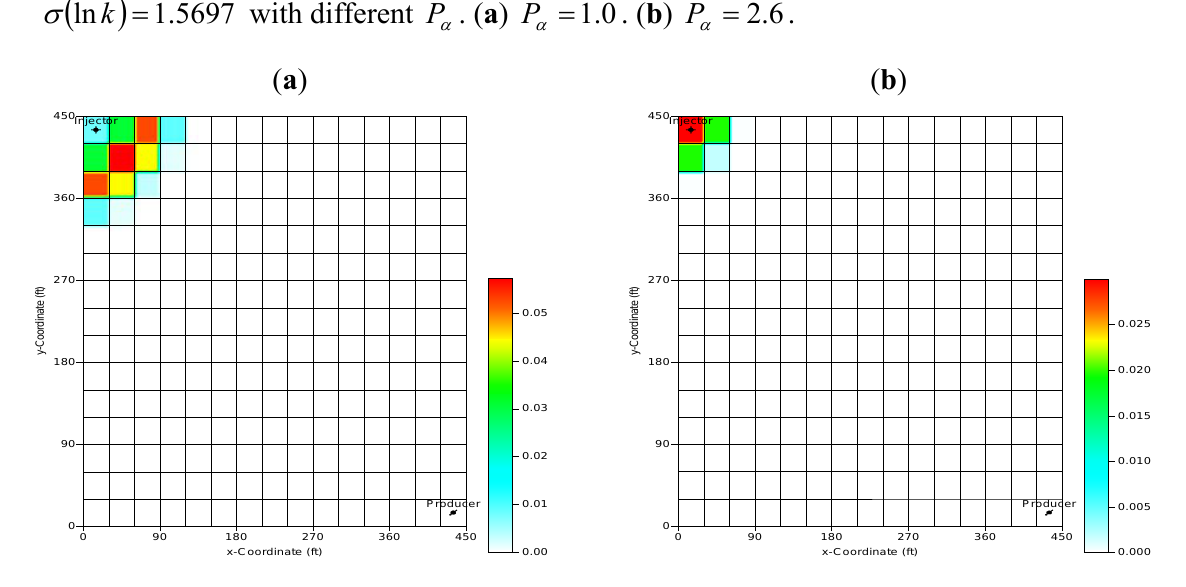
Figure 4. Polymer concentration in water phase of layer 5 at 1,283 days for 0/ =